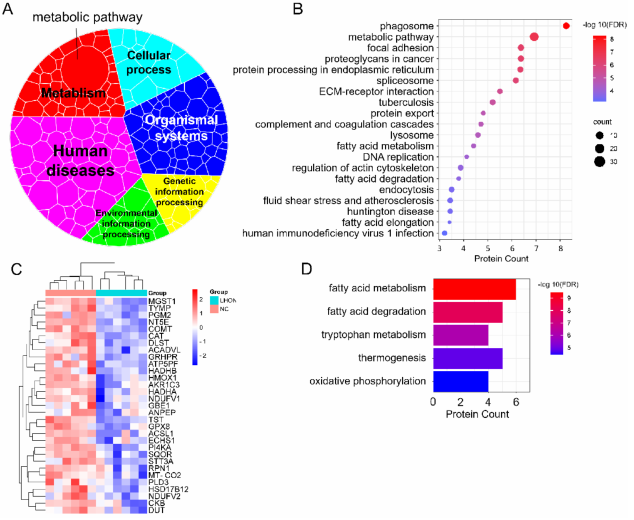
Figure 6. Fatty acid metabolism dysfunction in LHON fibroblasts (m.G11778A). ( A ) Voronoi tree map of differential pathways enriched by downregulated DEPs. ( B ) Kobas KEGG enrichment of downregulated DEPs. The top 20 items ranked by –log 10(FDR) are listed. ( C ) Downregulated DEPs involved in metabolic pathways were plotted as a heatmap. ( D ) Detailed KEGG enrichment of the downregulated DEPs participated in metabolic pathways. Items were ranked by –log